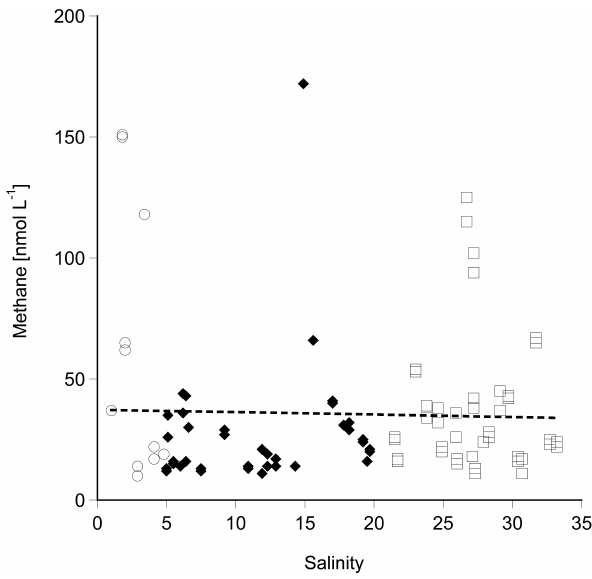
Figure 7. Methane concentration vs. salinity for riverine water (open circles), mixed water (diamonds) and polar water (open squares). The dotted line indicates a regression line for all data points ( r 2 = 0 . 01, p = 0 . 7, n =